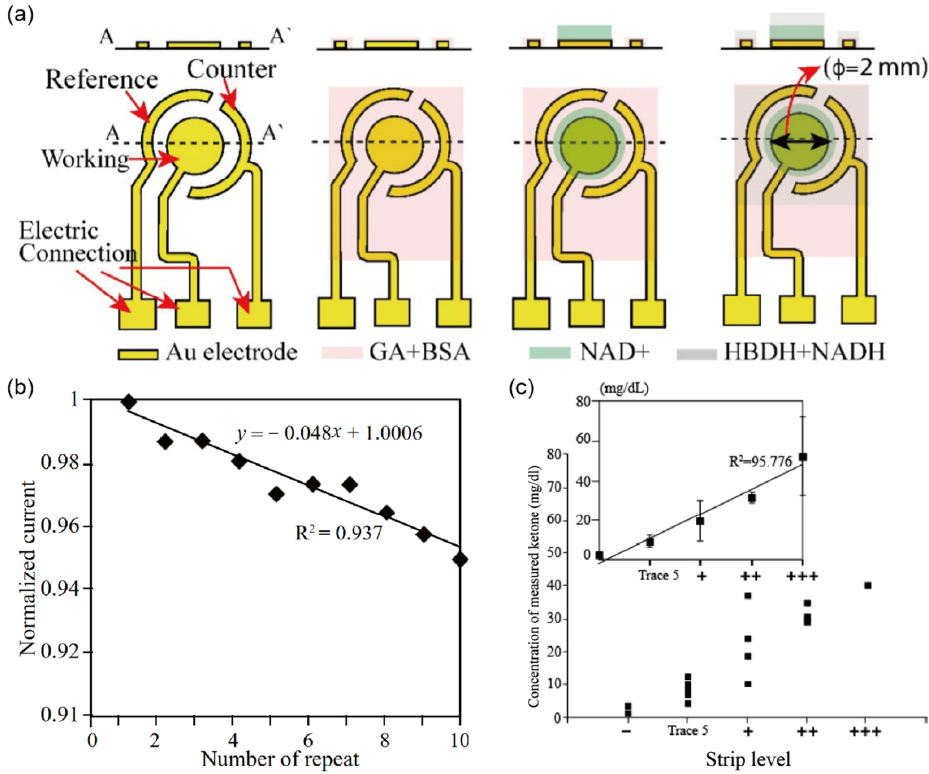
Figure 5. Selective detection of ketone bodies in clinical samples using multi-layer enzyme biosen- sors ( a ) Schematic diagram and layout of the electrode (working, counter, reference) structure. A Cr/Au layer with 50/100 nm thickness was fabricated by the conventional semiconducting process. ( b ) Comparable CV measurement during 10 repeated tests using 50 mg/dL of AcAc solution. The degradation of signal intensity is less than 5%. ( c ) Measured current plot comparing the electro ‐ chemical sensor and dipstick acquired from ketone levels (+++: up to 100 mg/dL; ++: up to 50 mg/dL; +: up to 10 mg/dL; trace 5: 10 mg/mL, and – is normal level) in 20 patients, (reprinted with permission from Ref. [38]; copyright 2021,